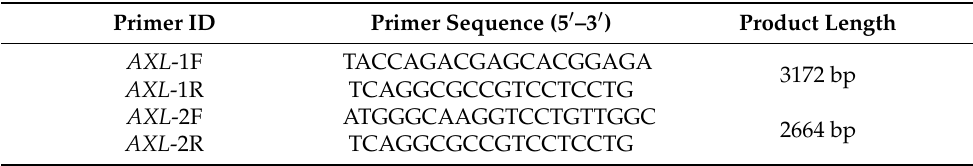
Table 1. The primers for Nested